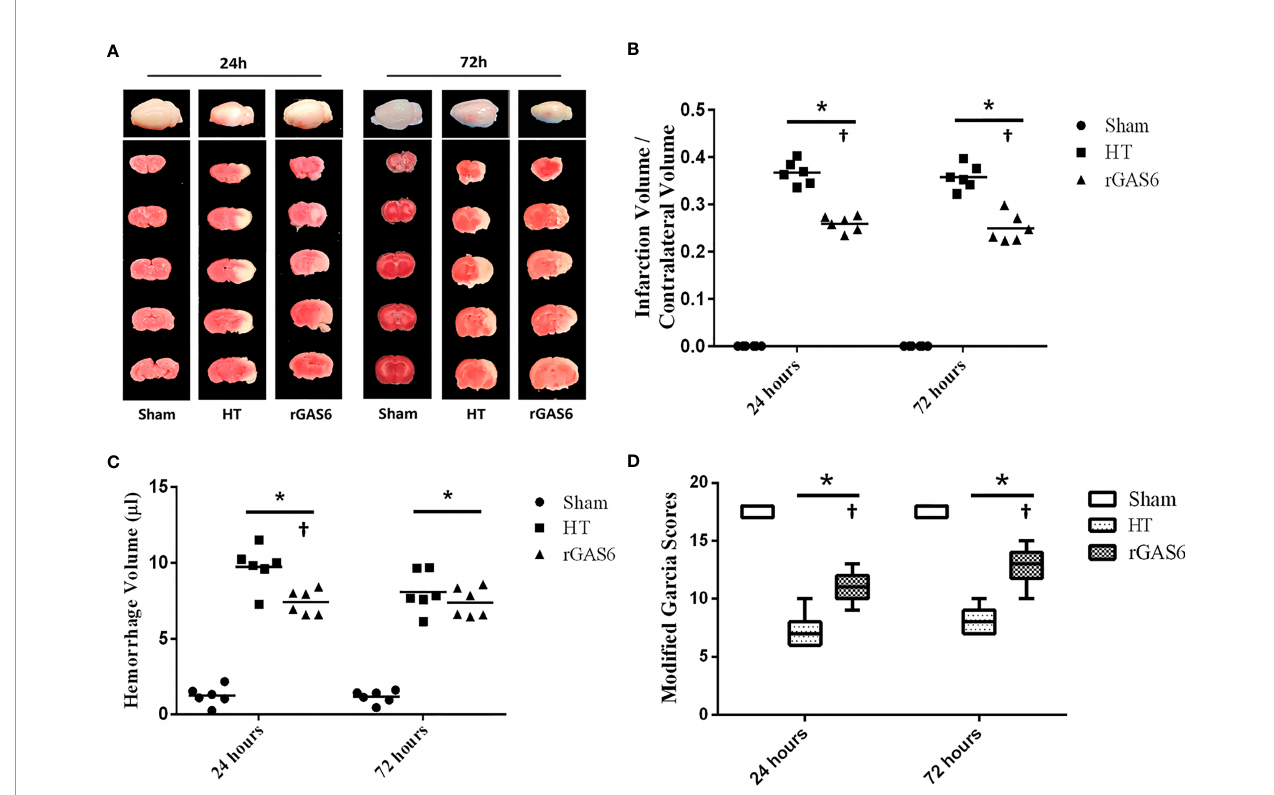
FIGURE 2 | Recombinant GAS6 (rGAS6) treatment reduces infarction and hemorrhagic volume and improves neurological de fi cits. The whole brain images and slices of rats in the sham, hemorrhagic transformation (HT), and rGAS6 groups stained with 2,3,5-triphenyltetrazolium chloride taken 24 and 72 h after MCAO, respectively, are shown separately in (A) (n=6 for each group at each time point). The infarction volume of each group 24 and 72 h after MCAO is shown in (B) . The hemorrhagic volume of each group 24 and 72 h after MCAO is shown in (C) (n=6 for each group at each time point). The neurologic score of each group 24 and 72 h after MCAO is shown in (D) (each group at each time point, n=18). * P < 0.05 versus sham; † P < 0.05 versus hemorrhagic transformation (HT) as shown via one-way analysis of variance followed by the Tukey test, or the Kruskal-Wallis test with Bonferroni